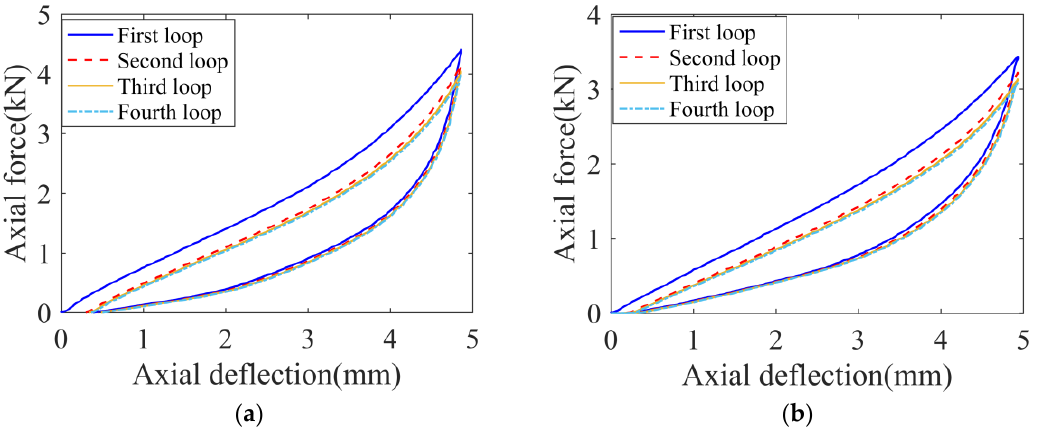
Figure 4. Experimental compression force-deflection history for the rubber sample. ( a ) 23°C and ( b ) 55°C.